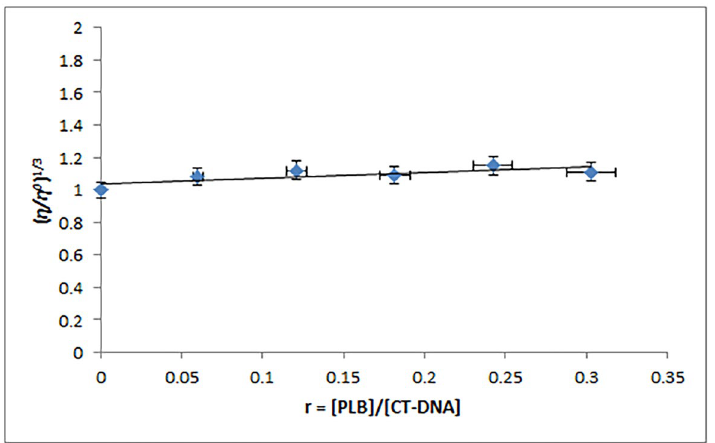
Figure 3. Influence of variable concentrations of PLB (0–25.0 μM) on the viscosity of CT-DNA (82.5 μM) in Tris–HCl buffer.